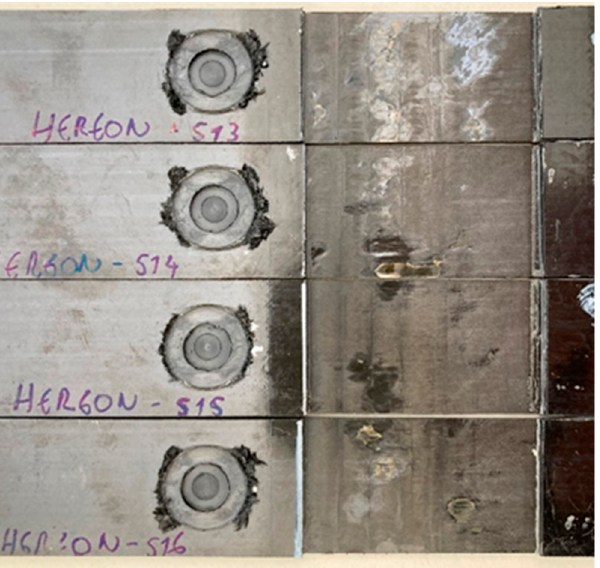
Figure 10. The RFFSW feature installed as CAF on crack lap shear specimens.